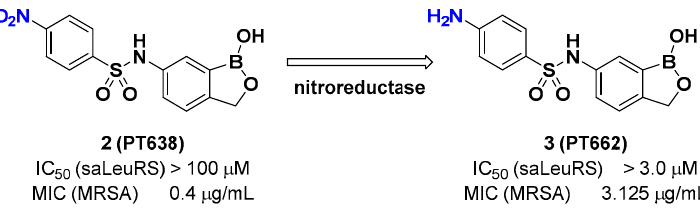
Figure 3. Benzoxaborole PT638 is reduced by a nitroreductase to PT662.